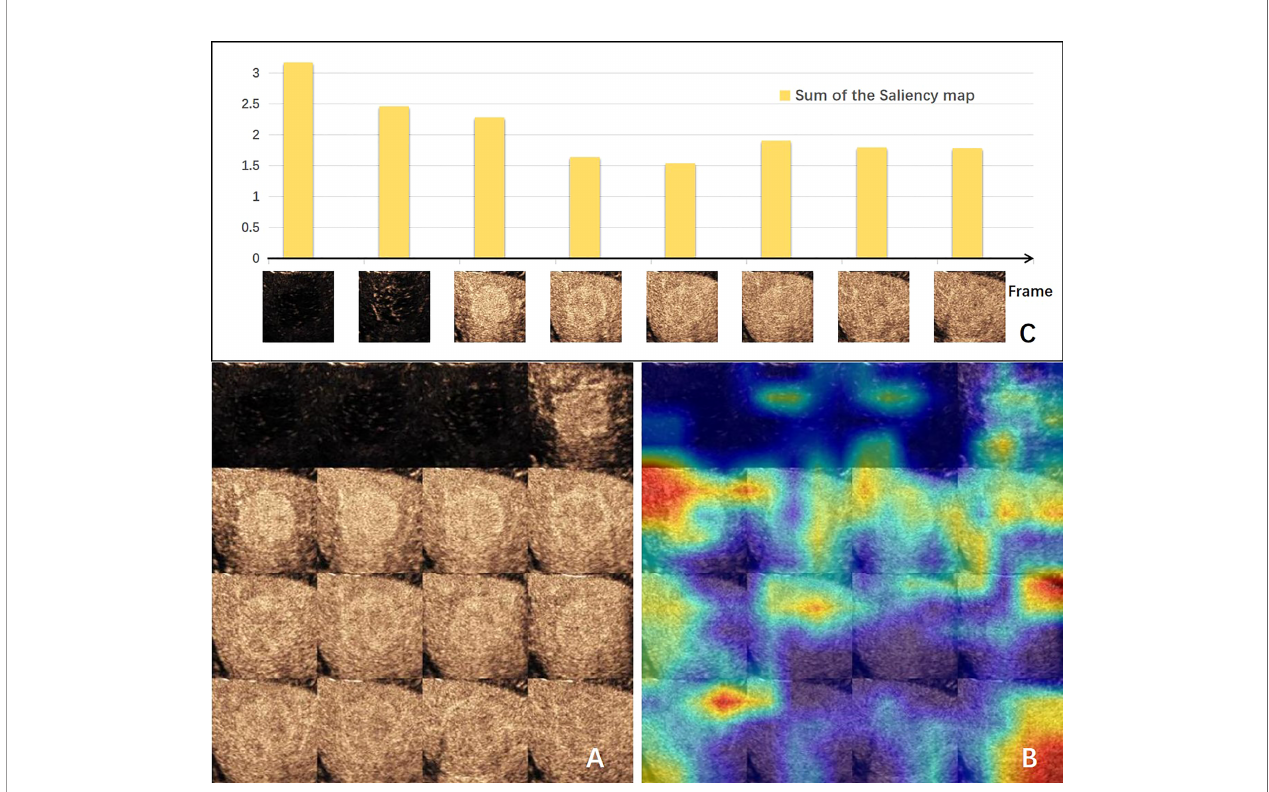
FIGURE 3 | Visual explanation of the deep convolution neural network (DCNN) model. (A) Input of CNN-based module made by 16-frame sliced images extracted from the 1-min video. (B) Corresponding gradient-weighted class activation map. Highlighted areas were the network paid attention for MVI prediction. (C) Bar chart of the sum of the saliency maps of each input frame for the GRU-based module. The value indicates the degree of the importance for this frame predicting MVI. CNN, convolution neural network; MVI, microvascular